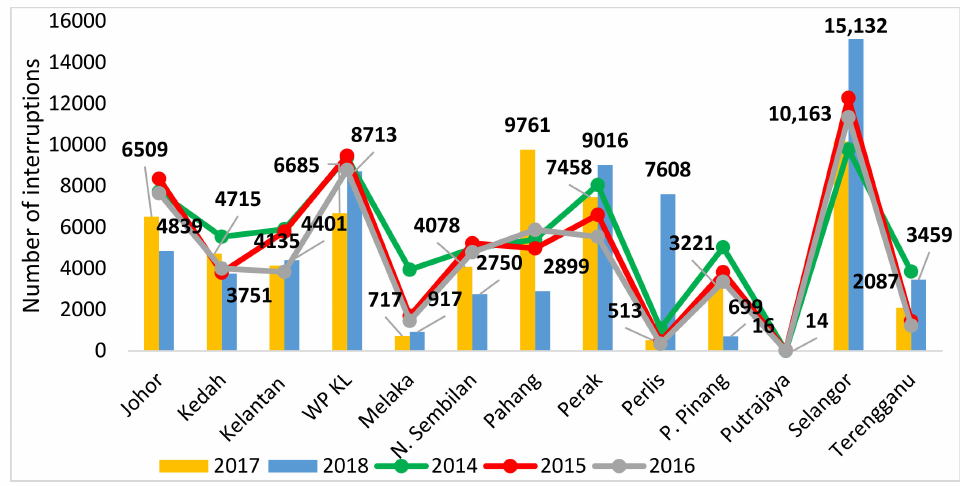
Figure 5. Number of interruptions by state in Peninsular Malaysia from 2014 to 2018